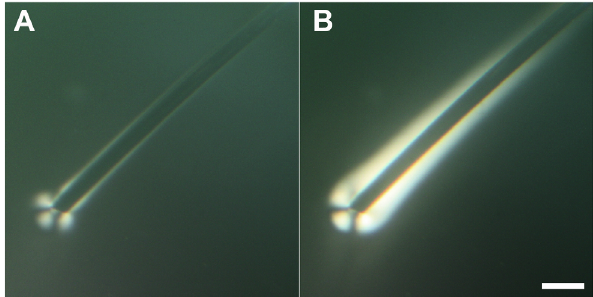
Figure 2. Optical images with crossed polarizers of an iron wire held first at 1 V for 7 min (Figure 1B) and then held at 2 V. A) 30 s after the potential was increased to 2 V. B) 90 s after the potential was increased to 2 V. The position of the crossed polarizers is drawn in Figure 1 panel A. The scale bar is 300 m m.